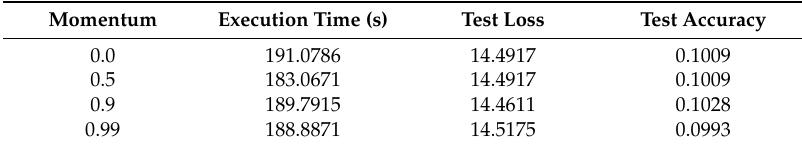
Table 9. E ff ect of momentum on CNN.